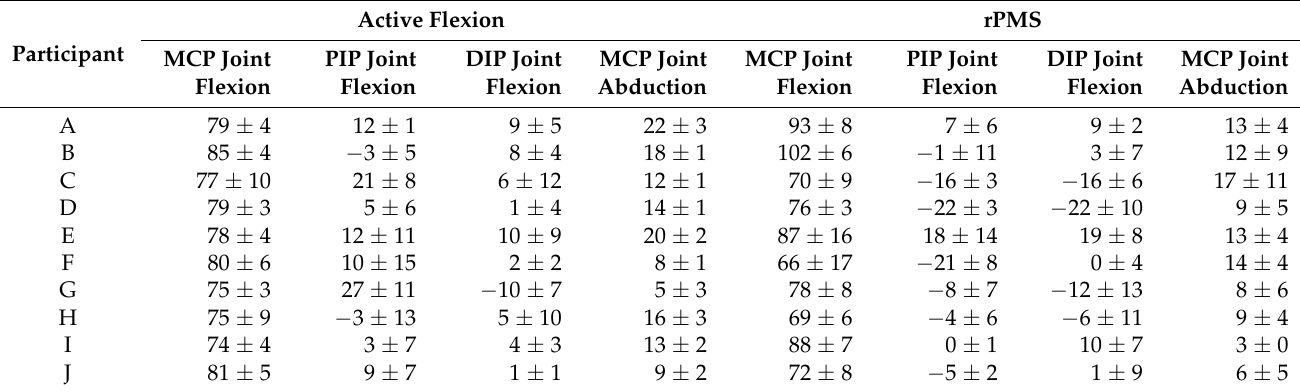
Table 1. Maximum joint angles between active MCP joint flexion and rPMS.